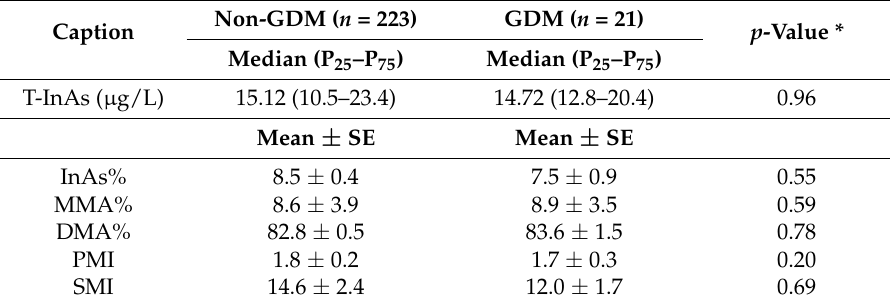
Table 2. Comparison of total urinary inorganic arsenic concentration, the percentages of the arsenic species and methylation indices, Arica